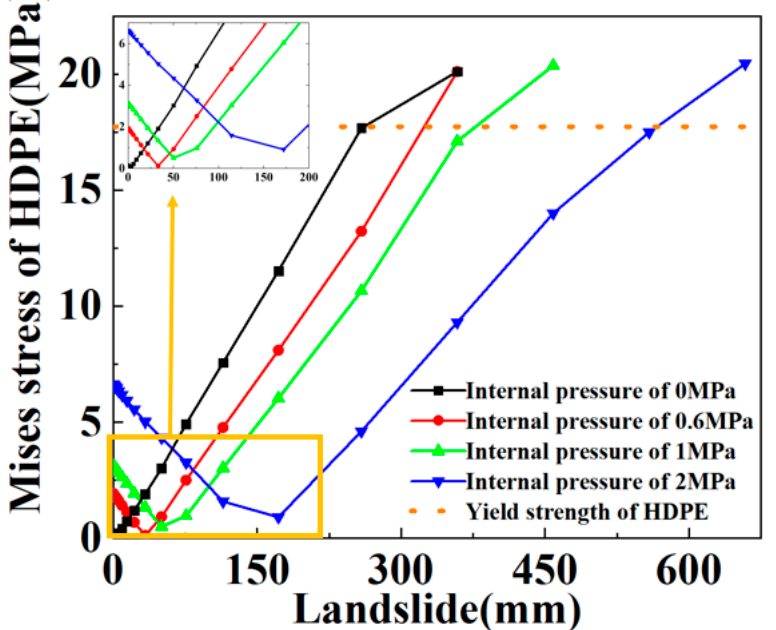
Figure 22. Influence of internal pressure on variation in Mises stress at point B of SWW-RTP with the landslide.